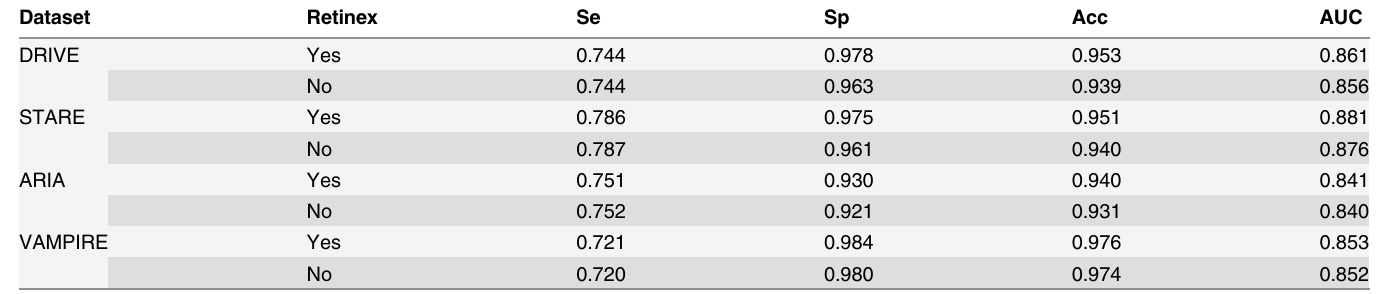
Table 1. Segmentation performance of Retinex pre-processing algorithm with and without applied on segmentation framework. Se : sensitivity; Sp : specificity; Acc : accuracy; AUC : area under the curve. Dataset